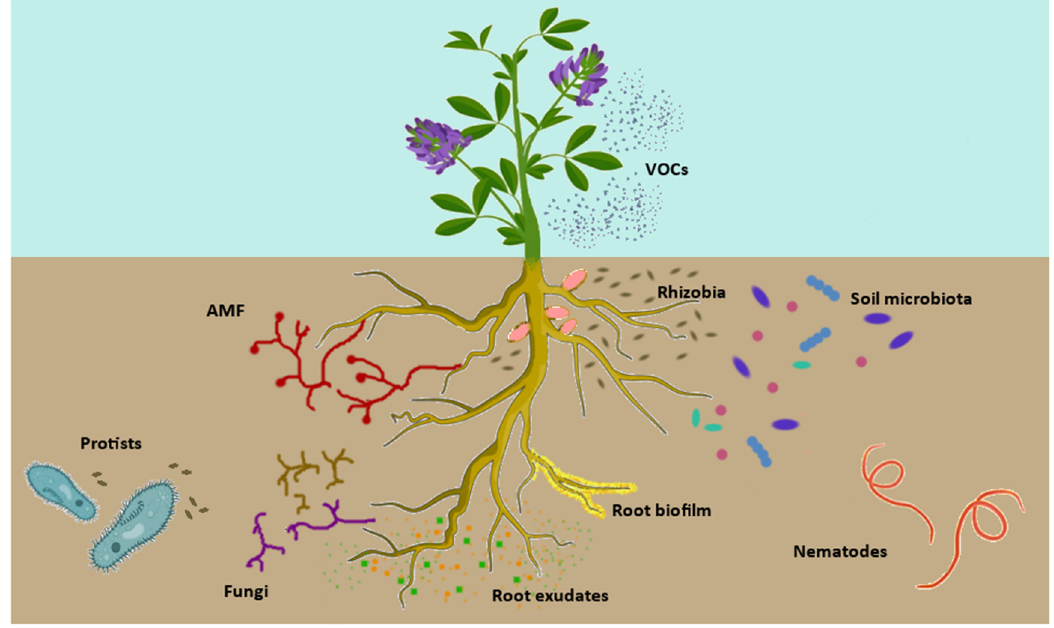
Figure 3. Cross-talk in the legume rhizosphere. Within- and among-kingdom interactions giving rise to modulation of symbiotic establishment are depicted, spanning from protists’ role as grazers of rhizobia to fungi, soil microbiota and nematodes which are attracted toward roots and may transport rhizobia.